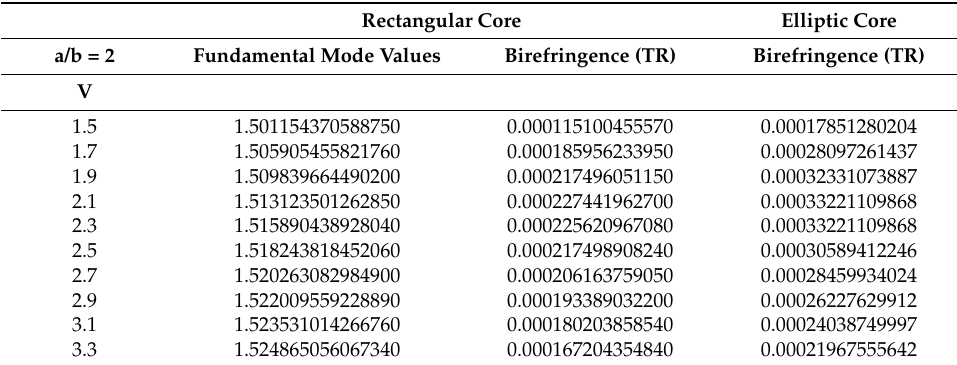
Table 8. Comparison of birefringence for elliptical and orthogonal core